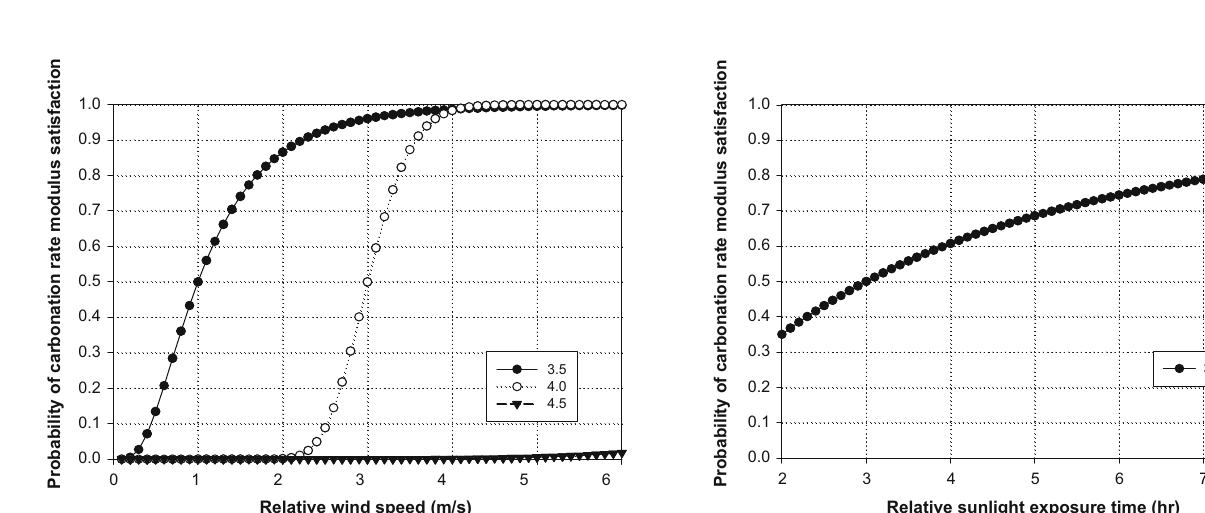
Fig. 7 Satisfaction curve of sunlight exposure time parameter for combine carbonation depth (7, 8, 9 mm).